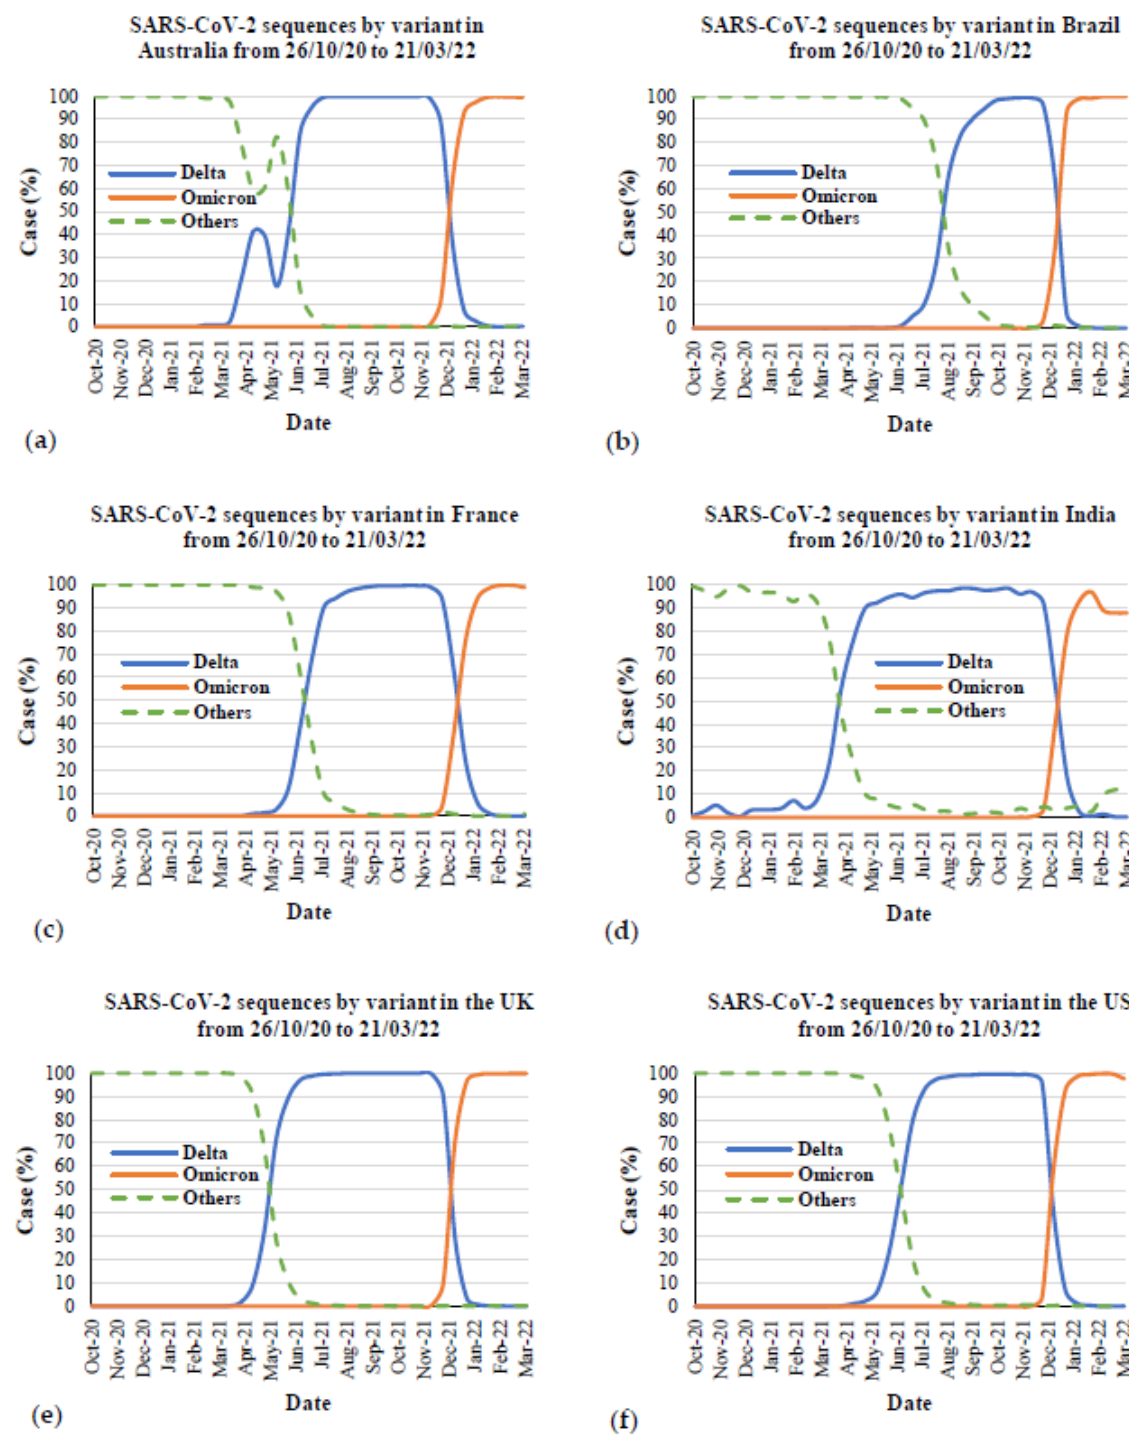
Figure 11. SARS-CoV-2 sequences by variant in Australia and the most affected countries from 26 October 2020 to 21 March 2022: ( a ) Australia, ( b ) Brazil, ( c ) France, ( d ) India, ( e ) the UK, and ( f ) the